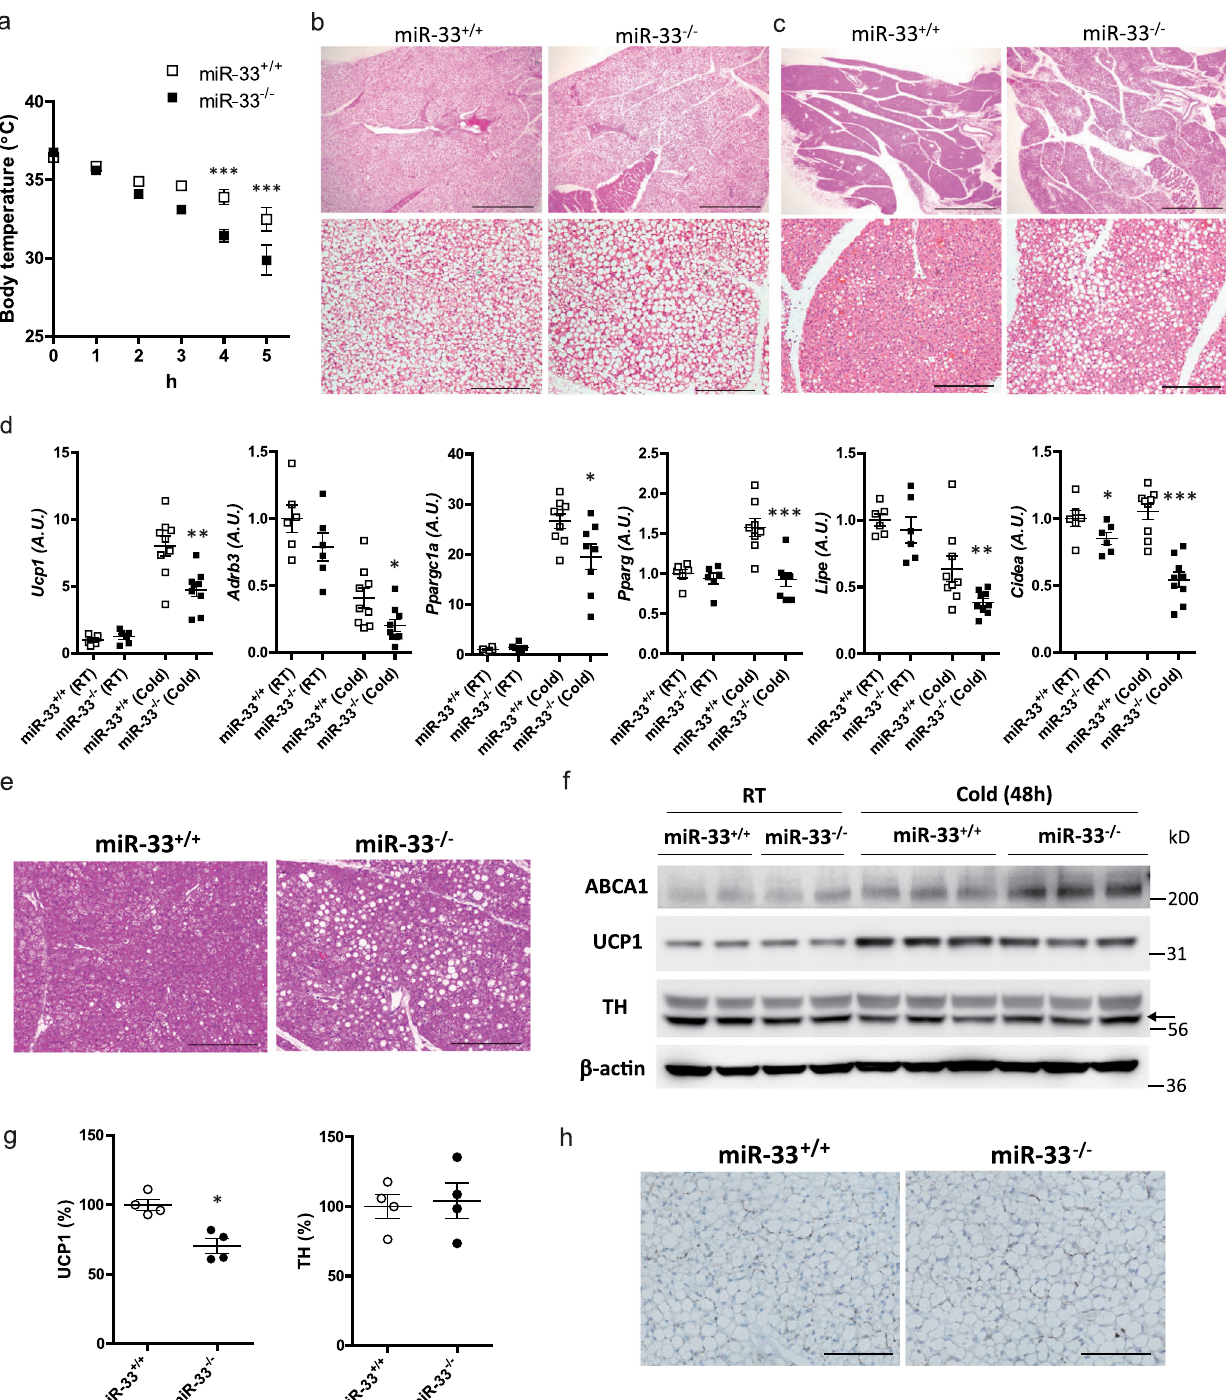
(Supplementary Fig. 2e – g). These data indicate that BAT activation and function are impaired in miR-33 − / − mice when fed an HFD, which may contribute to the increased obesity of these